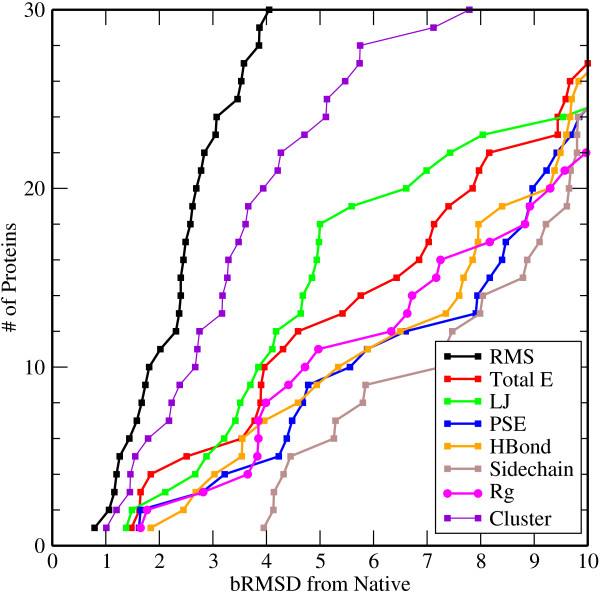
Enrichment. Enrichment of the best decoys by CαRMSD, total energy in PFF01, and its components (Lennard-Jones, Solvation Energy, Hydrogen Bonding, Sidechain Electrostatics), Radius of Gyration and the clustering technique described in the text. The vertical axis counts the number of proteins in the database that yield a best decoy according to chosen criterion.